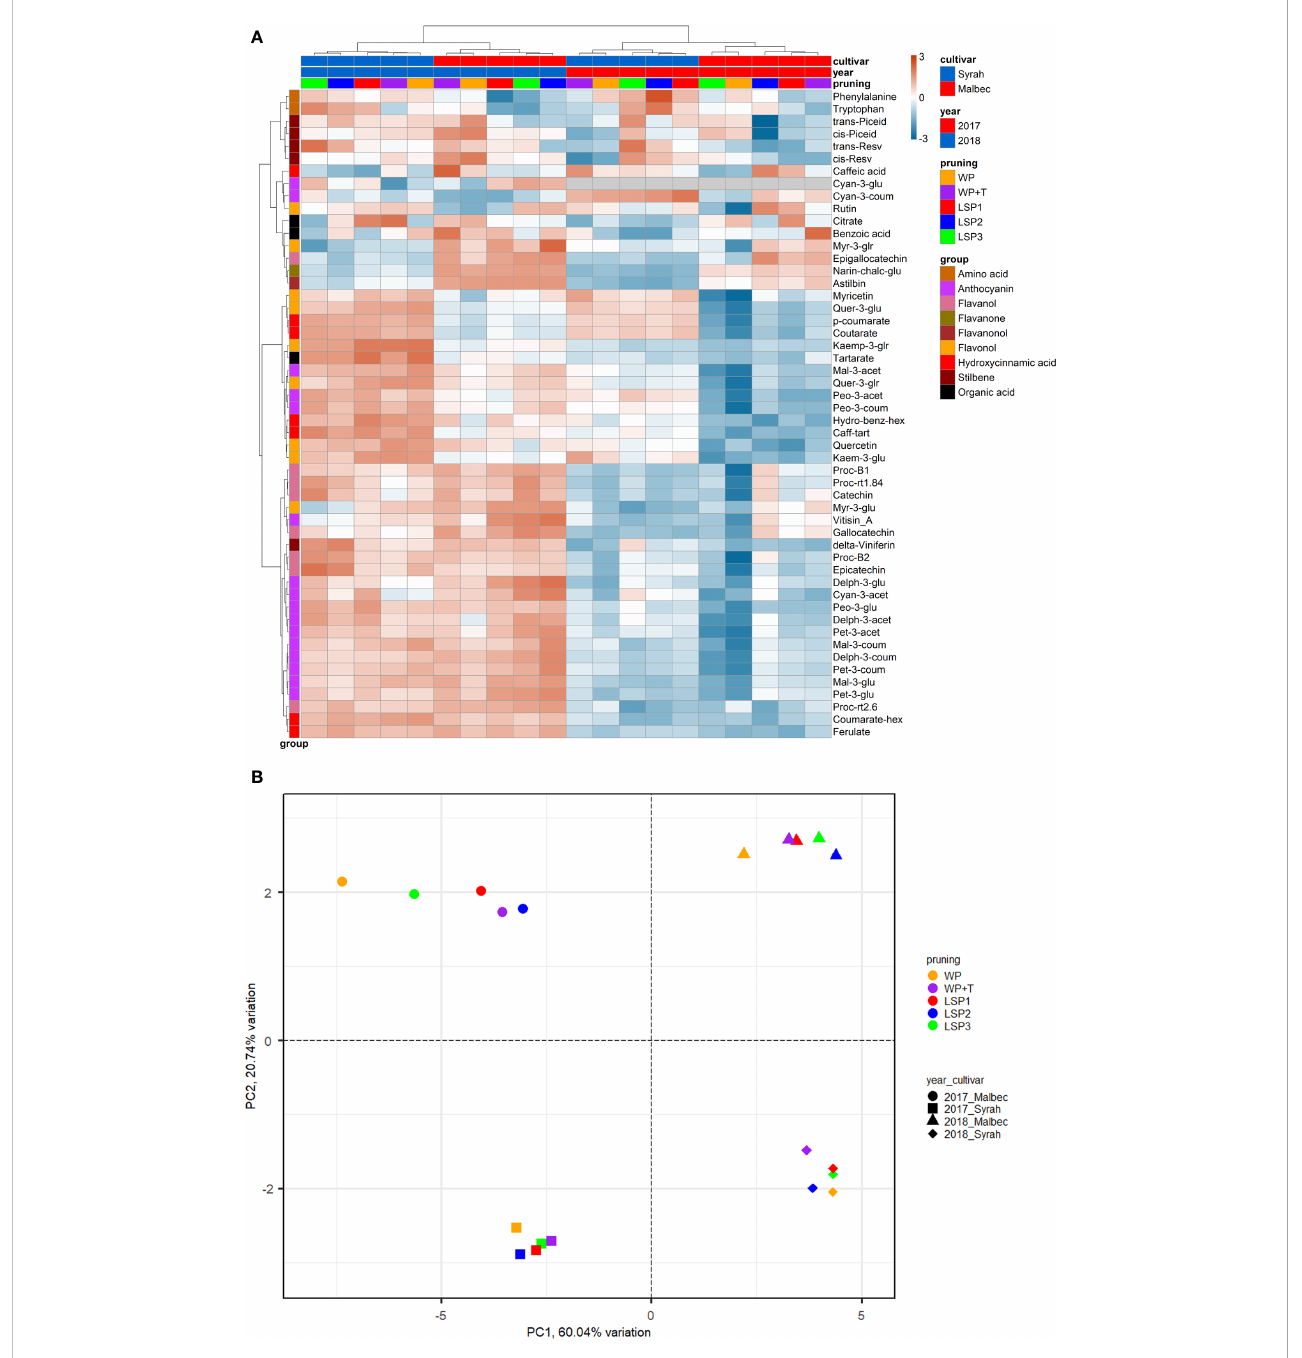
FIGURE 3 Heatmap and 2D PCA score plot of annotated LC-MS-based metabolites in wine Samples. (A) Hierarchical clustering heatmap obtained from the cluster analysis sharply divided the samples by year and then cultivar and pruning. (B) PCA analysis suggests that the wine samples were clustered by ‘ year ’ (2017 vs 2018) and then by ‘ cultivar ’ (Malbec vs